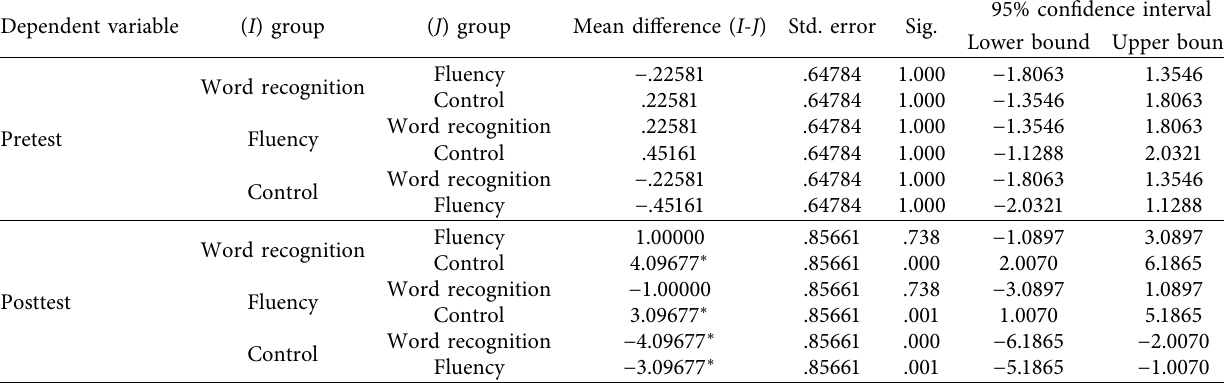
Table 3: Comparing the posttests of all